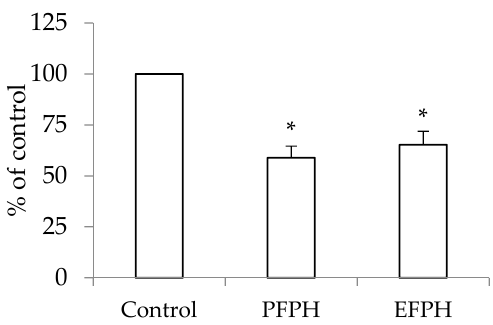
Figure 6. Relative thioredoxin reductase activity in undifferentiated Caco2/TC7 cells treated (24 h) or not with fenugreek proteins hydrolysates. Data are presented as mean ± SD. The experiment was done in duplicate (each performed with six determinations). Superscripted (*) means are significantly different ( p ≤ 0.05) compared to their respective control. Control: Untreated cells. PFPH: Purafect fenugreek proteins hydrolysate. EFPH: Esperase fenugreek proteins hydrolysate. The hydrolysates were used at a final concentration of 1 mg/mL.